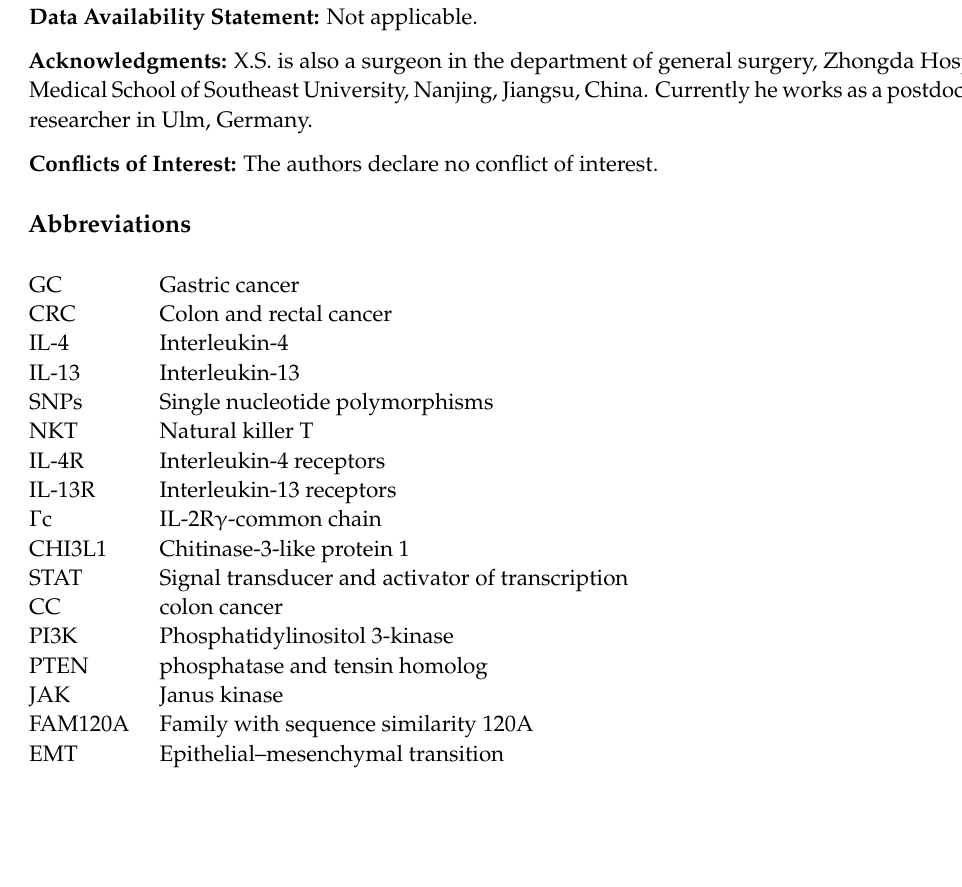
cells, Table S3: Effects of IL-4/IL-13 in CRC mouse models or patients, Table S4: Polymorphisms of IL-4/IL-13 and their receptors in GC, Table S5: Polymorphisms of IL-4/IL-13 and their receptors in